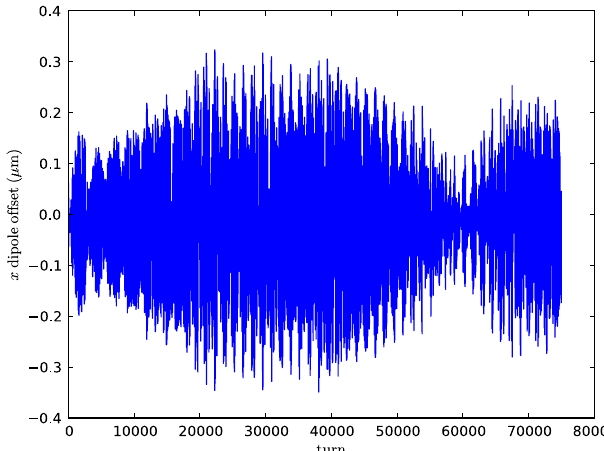
FIG. 18. (Color) The x dipole moment of a representative bunch in a 36-on-36 simulation with C ¼ (cid:1) 2 with beam-beam effects and beams separated showing no obvious instability within the limits of the